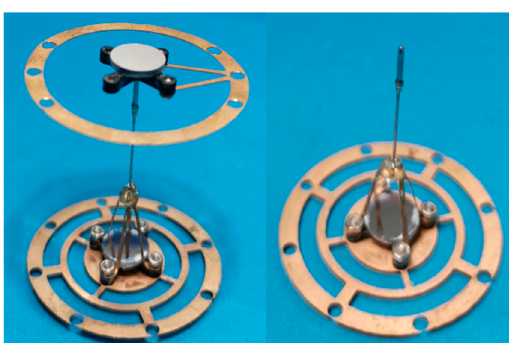
Figure 2. Photo of the elastic mechanisms and the rod.